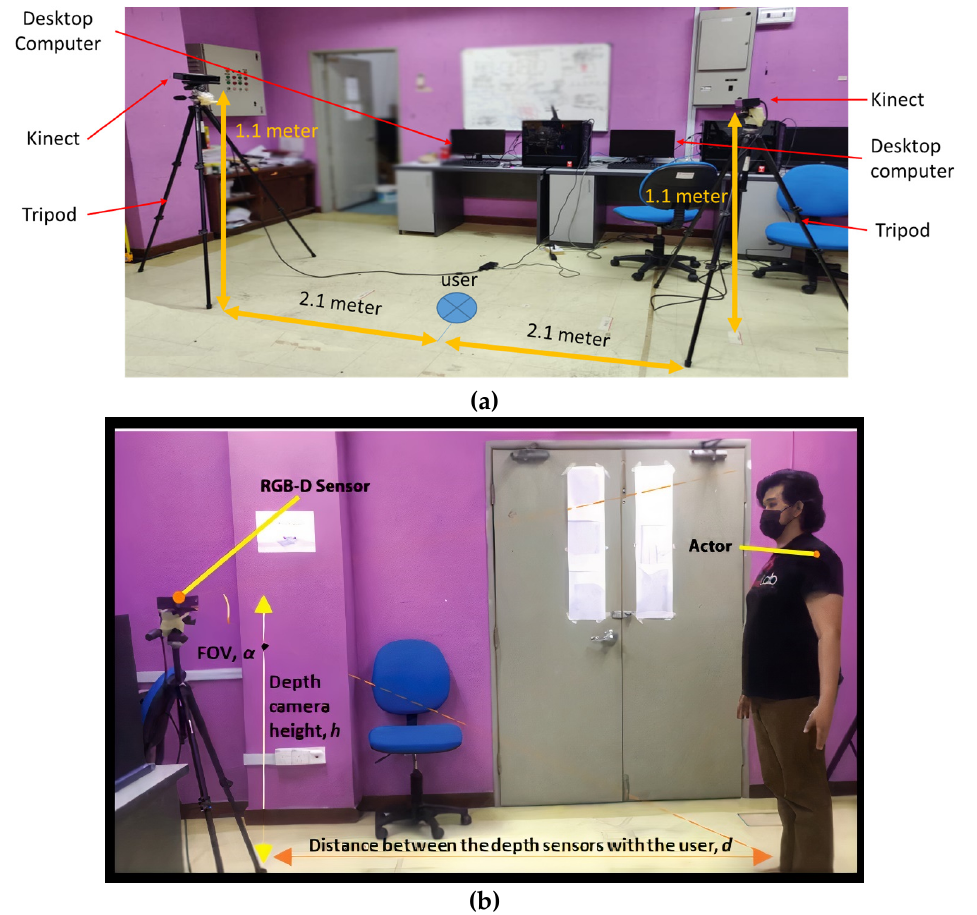
Figure 8. The experimental setup. ( a ) The experimental setup using two Kinect. ( b ) The setup with user.